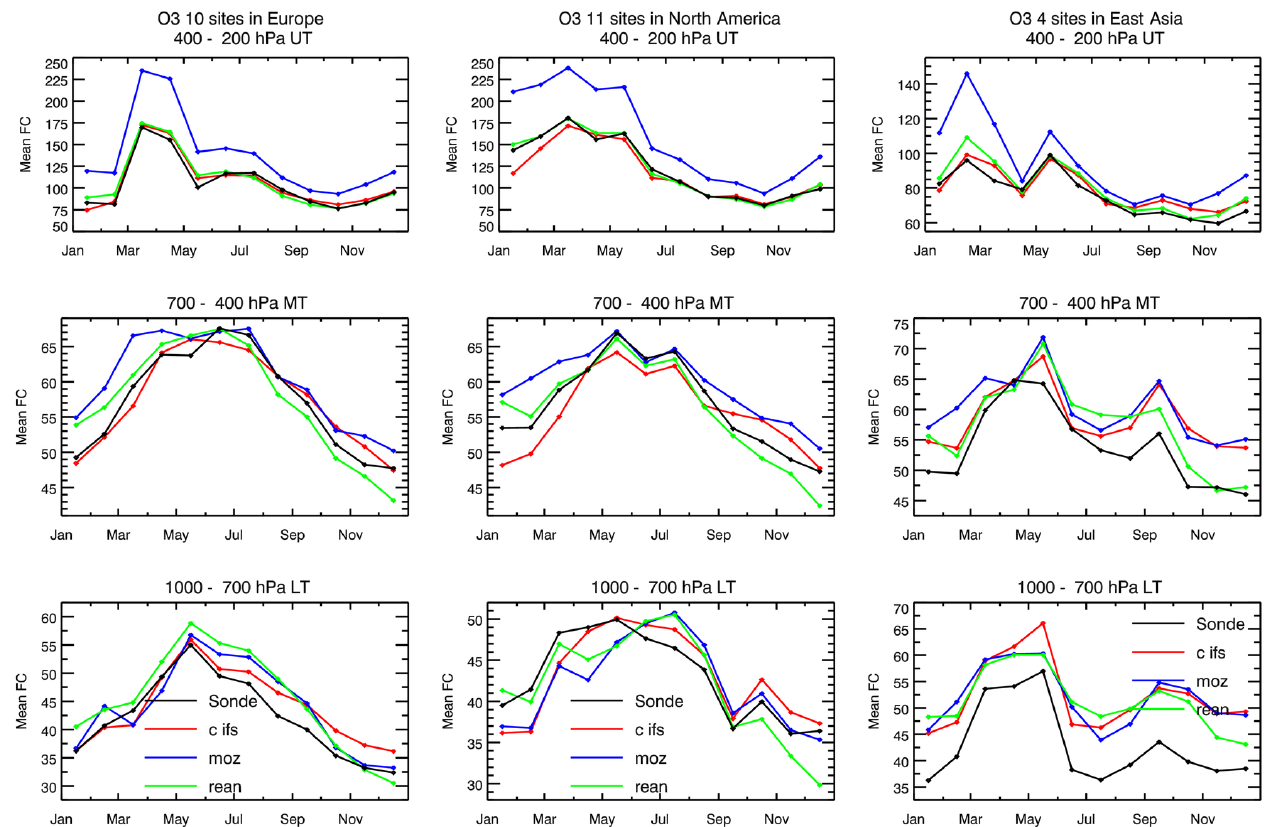
Figure 2. Tropospheric ozone volume mixing ratios (ppb) over Europe (left) and North America (middle) and East Asia (right) averaged in the pressure ranges 1000–700hPa (bottom), 700–400hPa (middle) and 400–200hPa (top) observed by ozonesondes (black) and simulated by C-IFS (red), MOZ (blue) and REAN (green) in